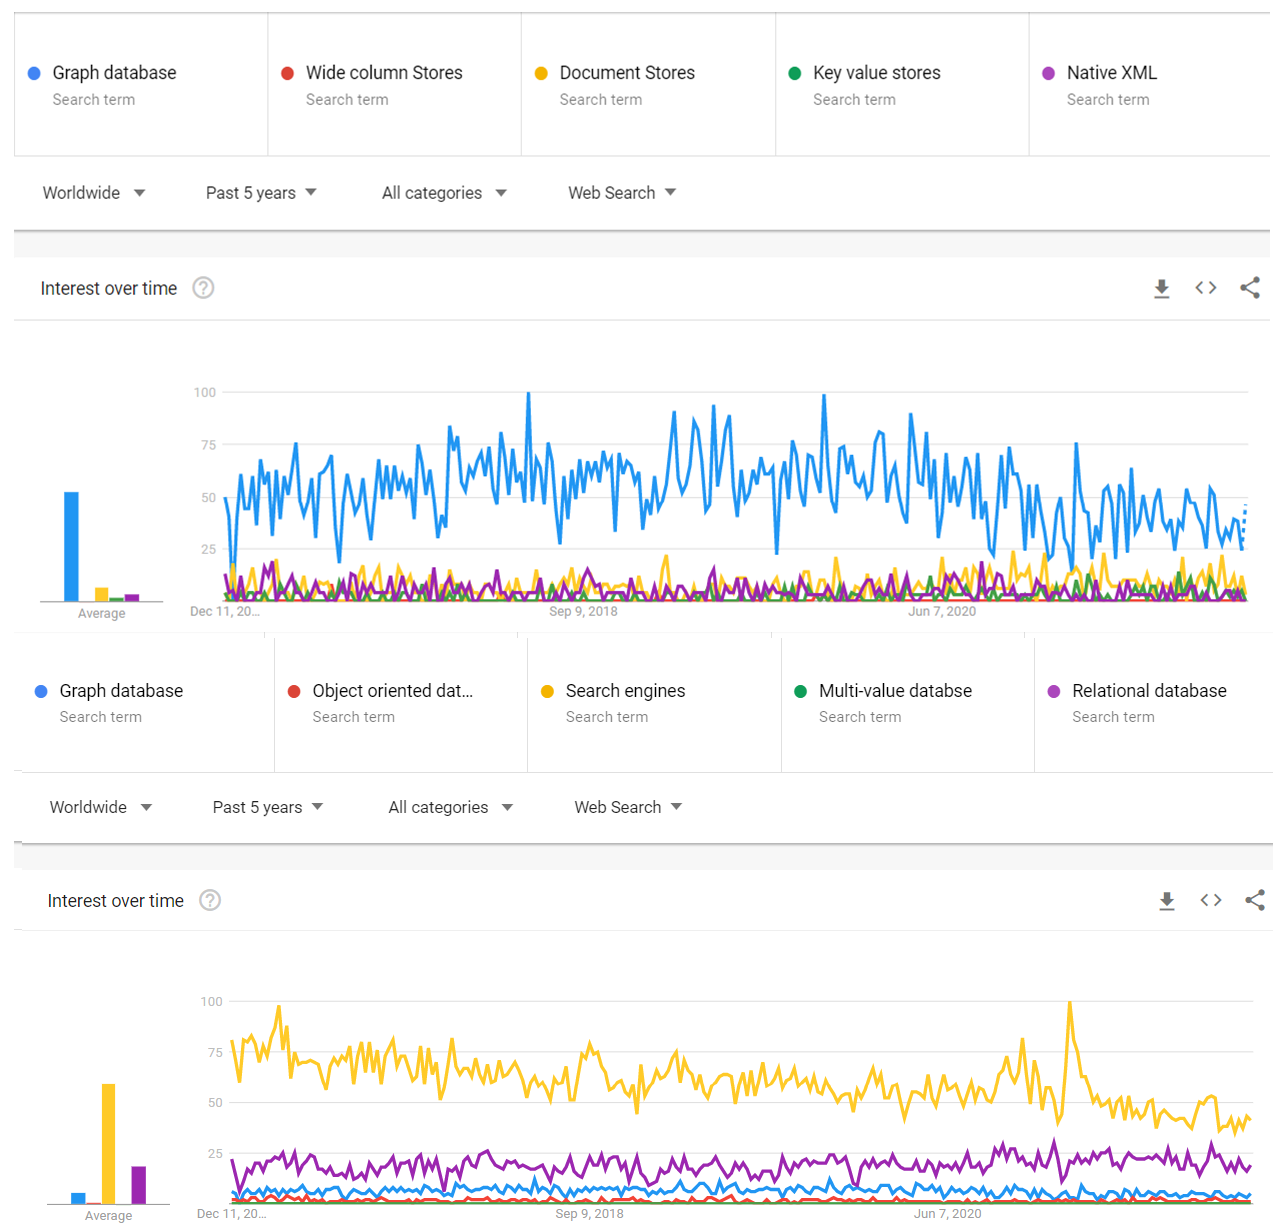
Figure 8. Database popularity in 2016–2021 based on search trends.